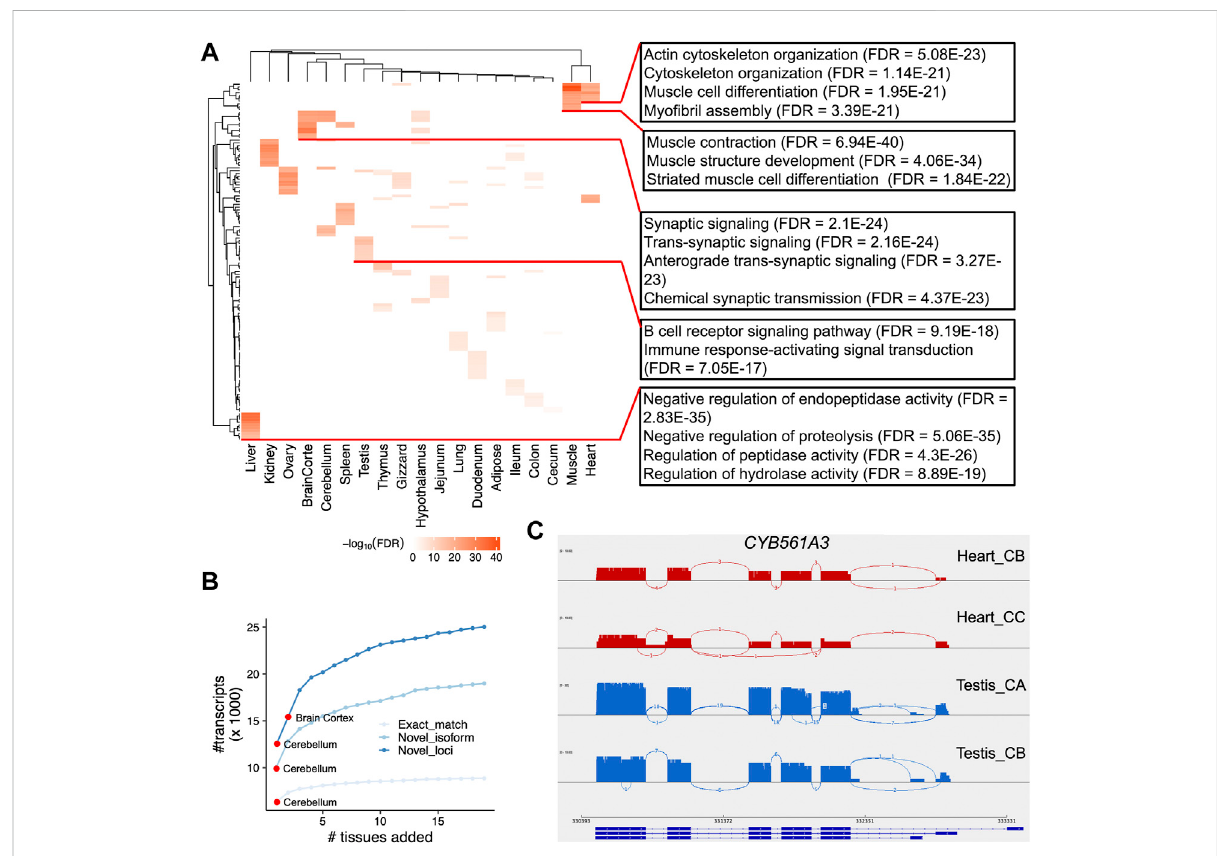
FIGURE 5 Functional enrichment of tissue-speci fi c transcripts and differential alternative splicing analysis. (A) Heatmap depicting the negative log 10 FDR (falsediscovery rate)valuesfor thetop10GeneOntology (GO)BiologicalProcessterms.Attherightside,weshow severalexamplesofGOterms,as well as their FDR values. (B) Number of unique transcripts detected as a function of tissues added. Transcripts are categories into three types (see Methods). (C) . Sashimi plots of CYB561A3 gene that showed DAS between heart (red) and testis